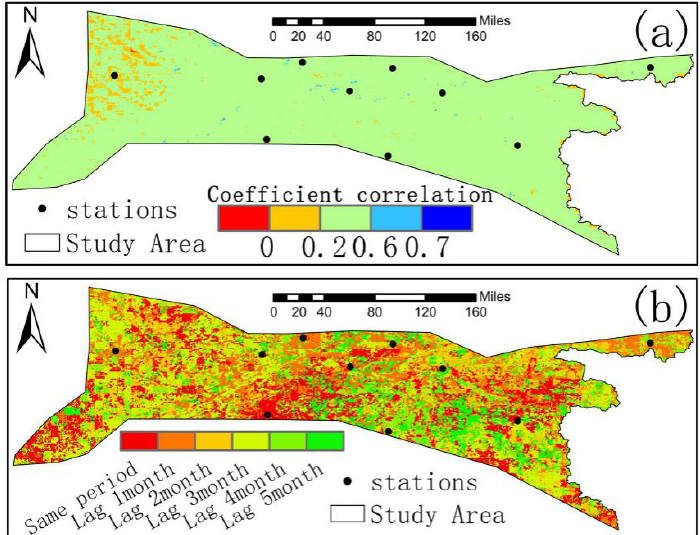
Figure 10. Spatial distribution of maximum cross-correlation ( a ) between NDVI and humidity index and time-lag response ( b ) in the Qinba region.